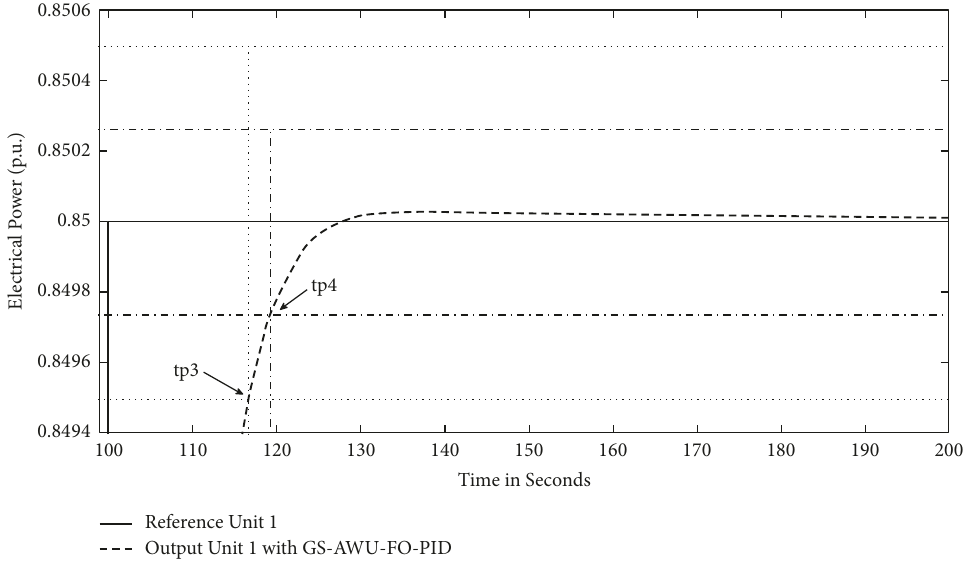
Figure 21: Step response of GS-PDF-FO with antiwindup, one operational unit, and h=1 (zoom).